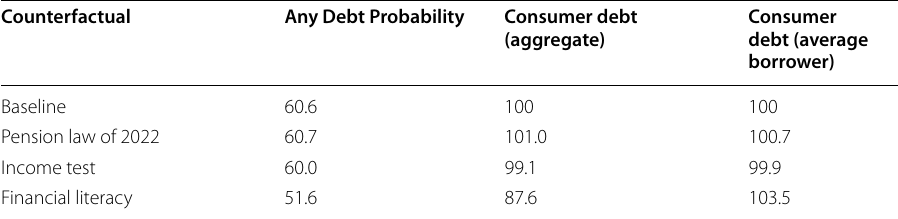
Table 9 Effect of different policies on the consumer debt amount (for all households and the average borrower) relative to the baseline (in %) and on the overall probability (in %) of being a